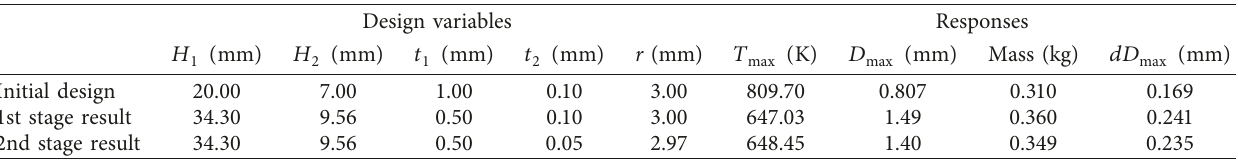
Table 14: Summary of 2-stage optimal results. Design